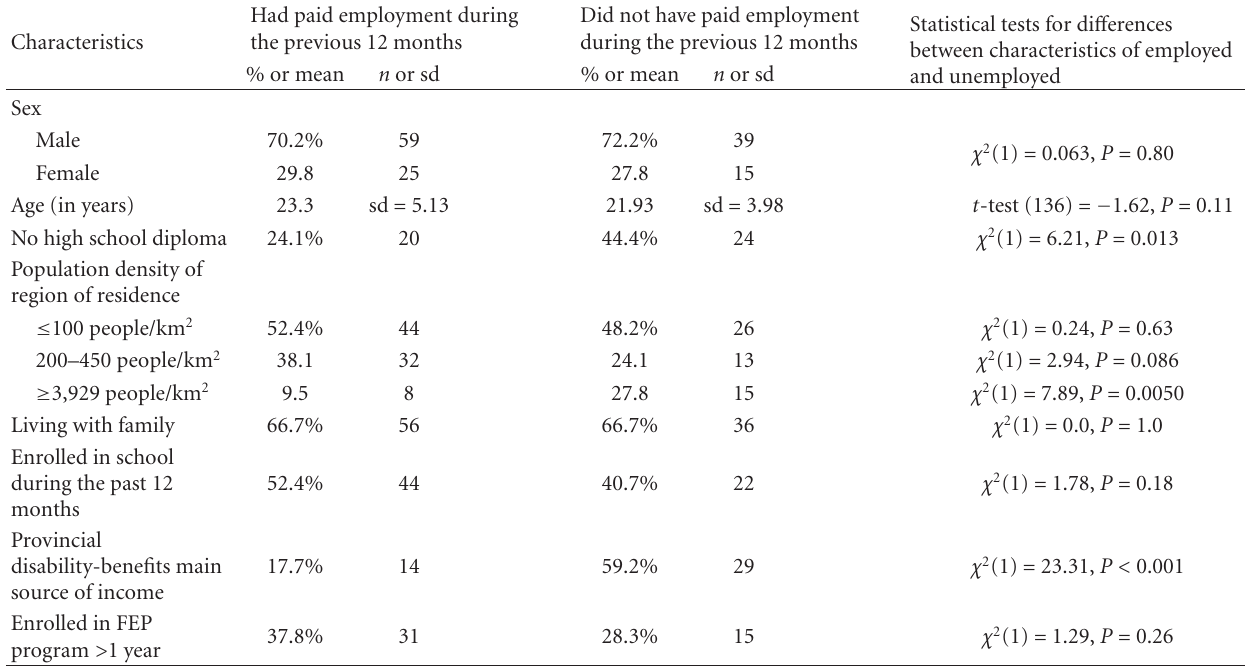
Table 1: Characteristics of FEP clients who did and did not have paid employment during previous 12